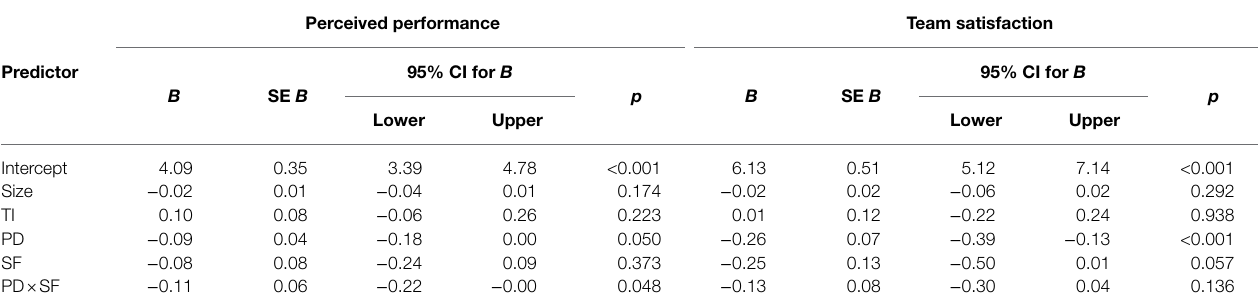
TABLE 2 | Moderated regression results for perceived performance ( N = 95) and team satisfaction ( N = 96). Predictor